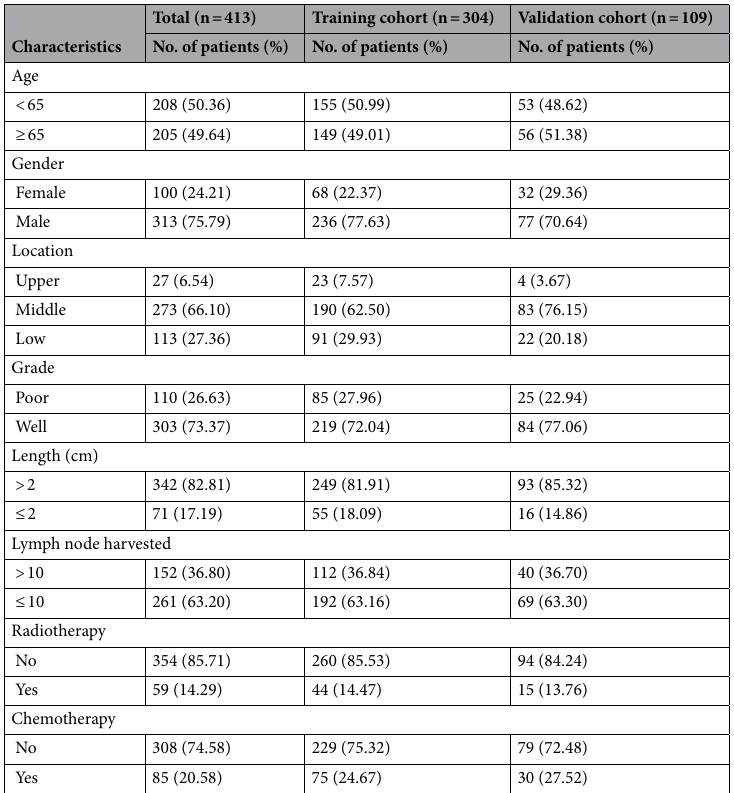
Table 1. Baseline characteristics of pT2N0M0 patients with